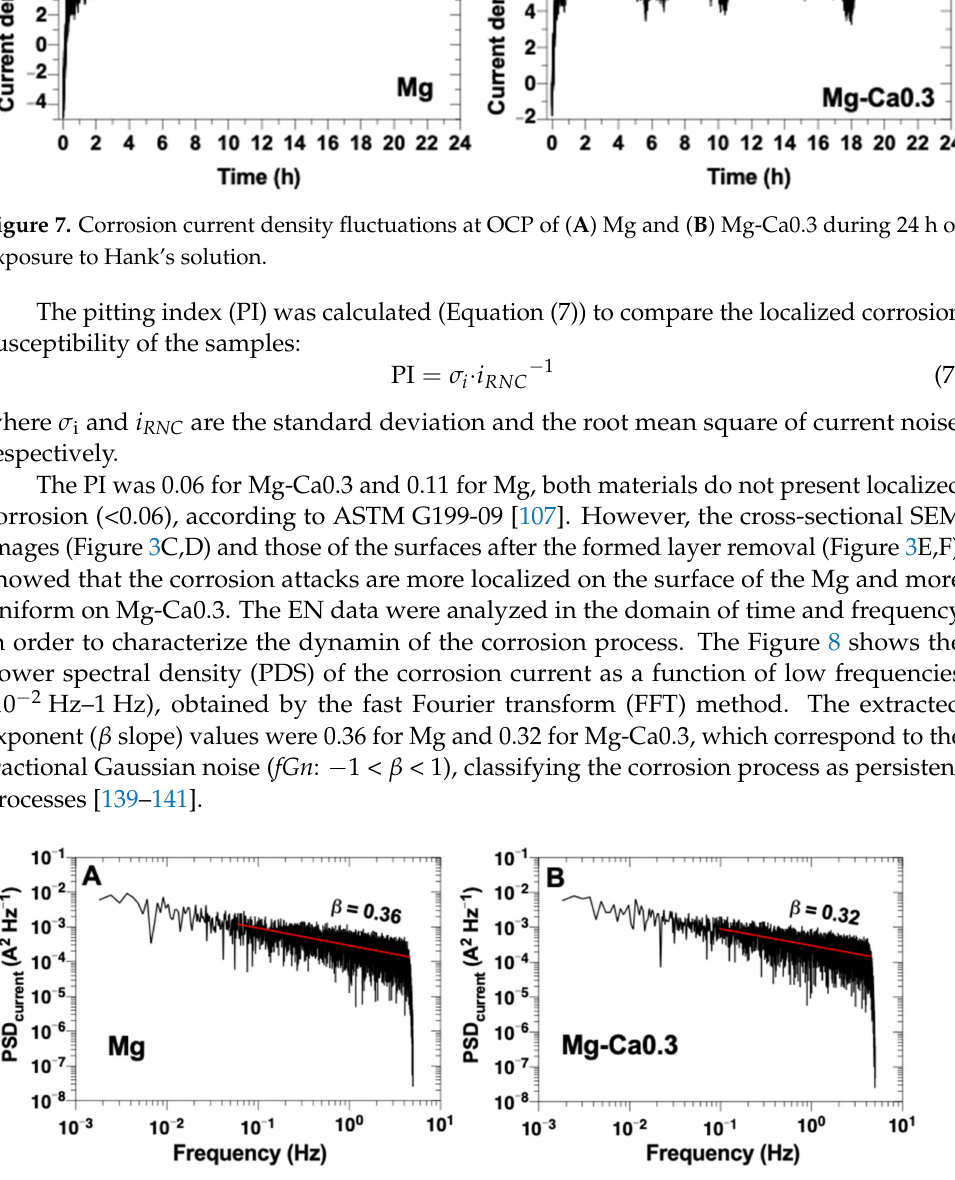
Figure 8. PSD of corrosion current density fluctuations vs. frequency in bi-logarithmic scale for Mg ( A ) and Mg-Ca0.3 alloy ( B ) after 24 h of immersion in Hank’s